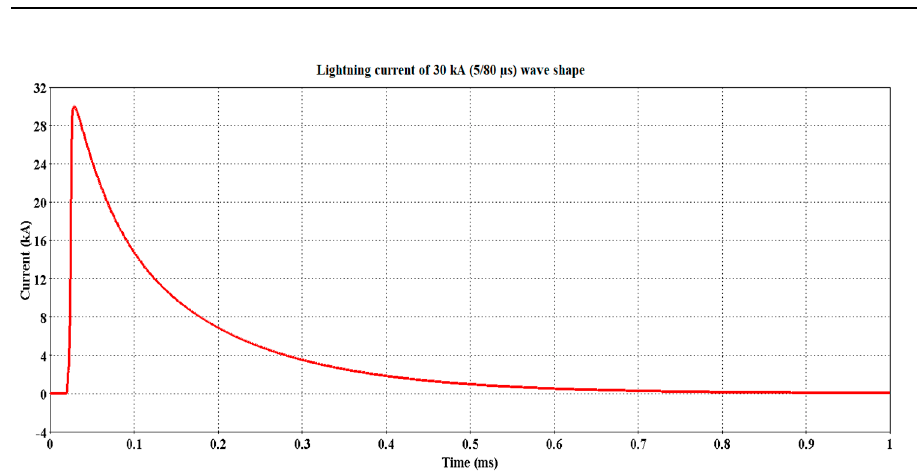
Figure 4. Lightning current 30 kA (5/80 µs) waveshape.